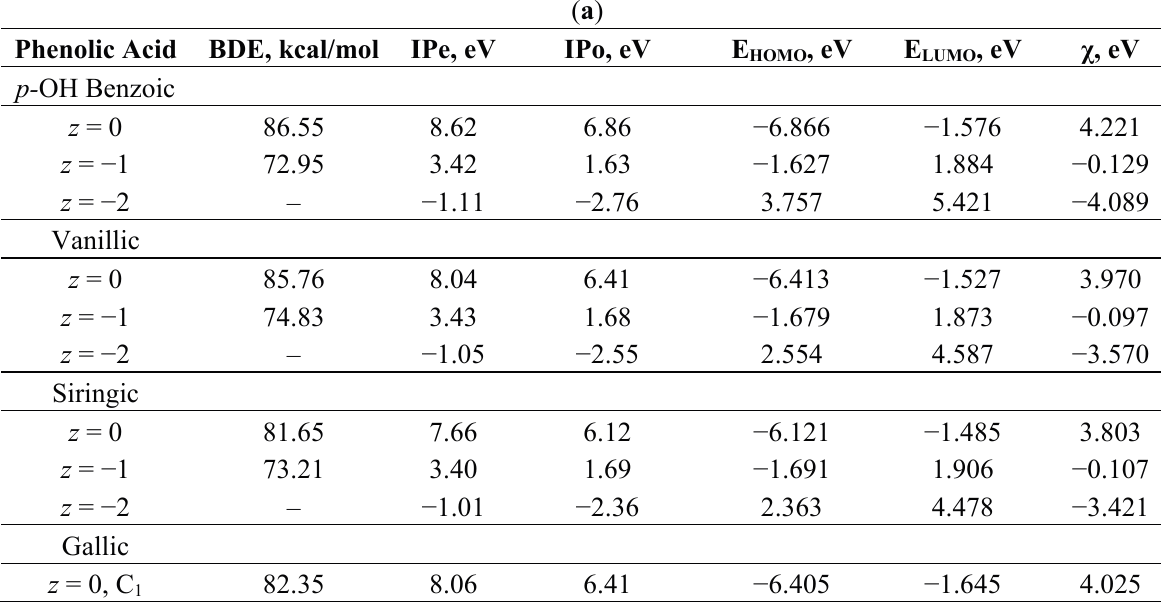
Table 6. ( a , b ) Thermodynamic and energy parameters of HB and HC acids in various states of ionization in the gas phase (298